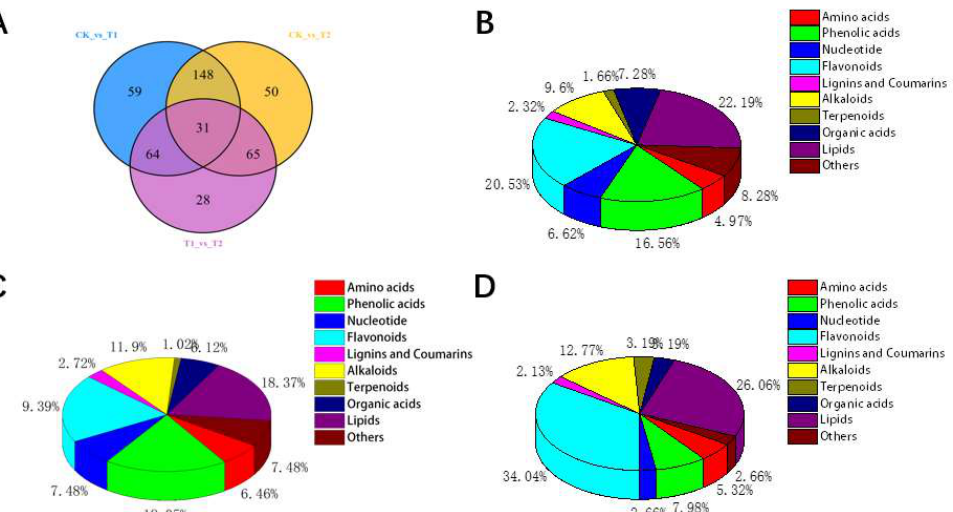
Figure 3. Venn diagrams and 3D pie charts of control maize plants and those exposed to T1 and T2 water stress treatments. T1 (Drought Stress at Seedling Stage), T2 (Drought Stress at Flowering Stage), CK (Conventional irrigation). ( A ) Venn diagram of differentially abundant metabolites between CK vs. T1, CK vs. T2, T1 vs. T2; ( B ) pie chart of the classification and proportion of the differentially abundant metabolites between T1 (drought treatment at seedling stage) and the control group, ( C ) between the T2 (drought treatment at flowering stage) and the control group, and ( D ) between T1 and T2 treatments.